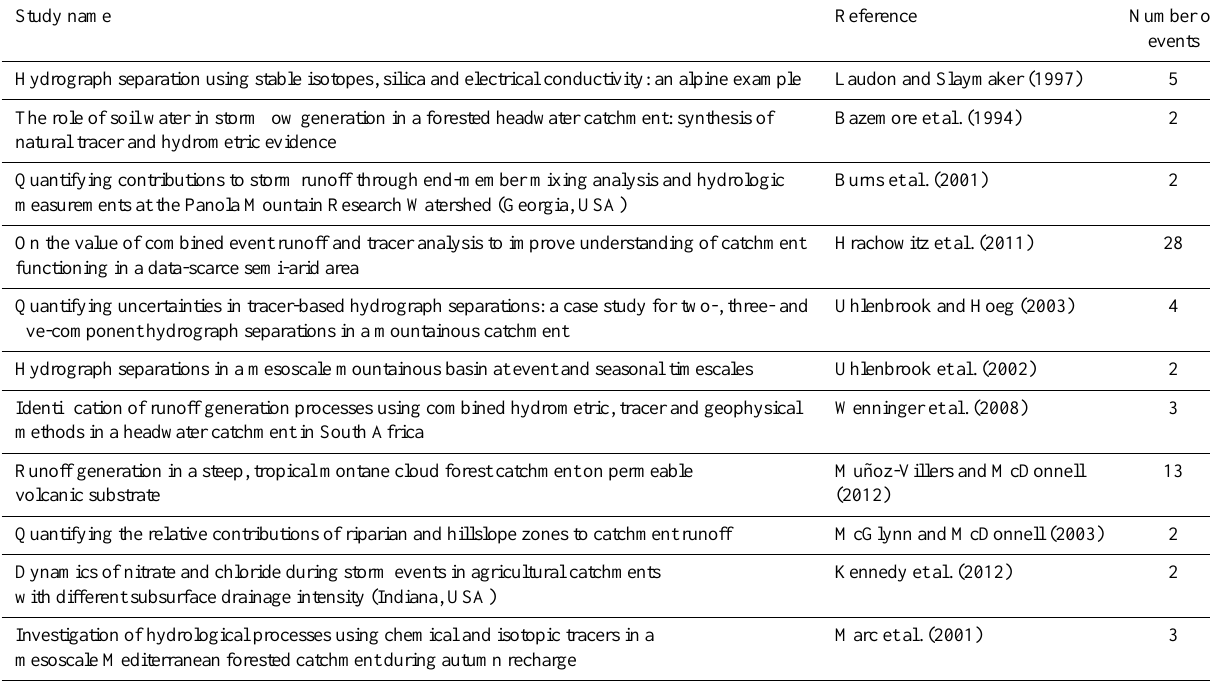
Table 7. Runoff studies with the number of events